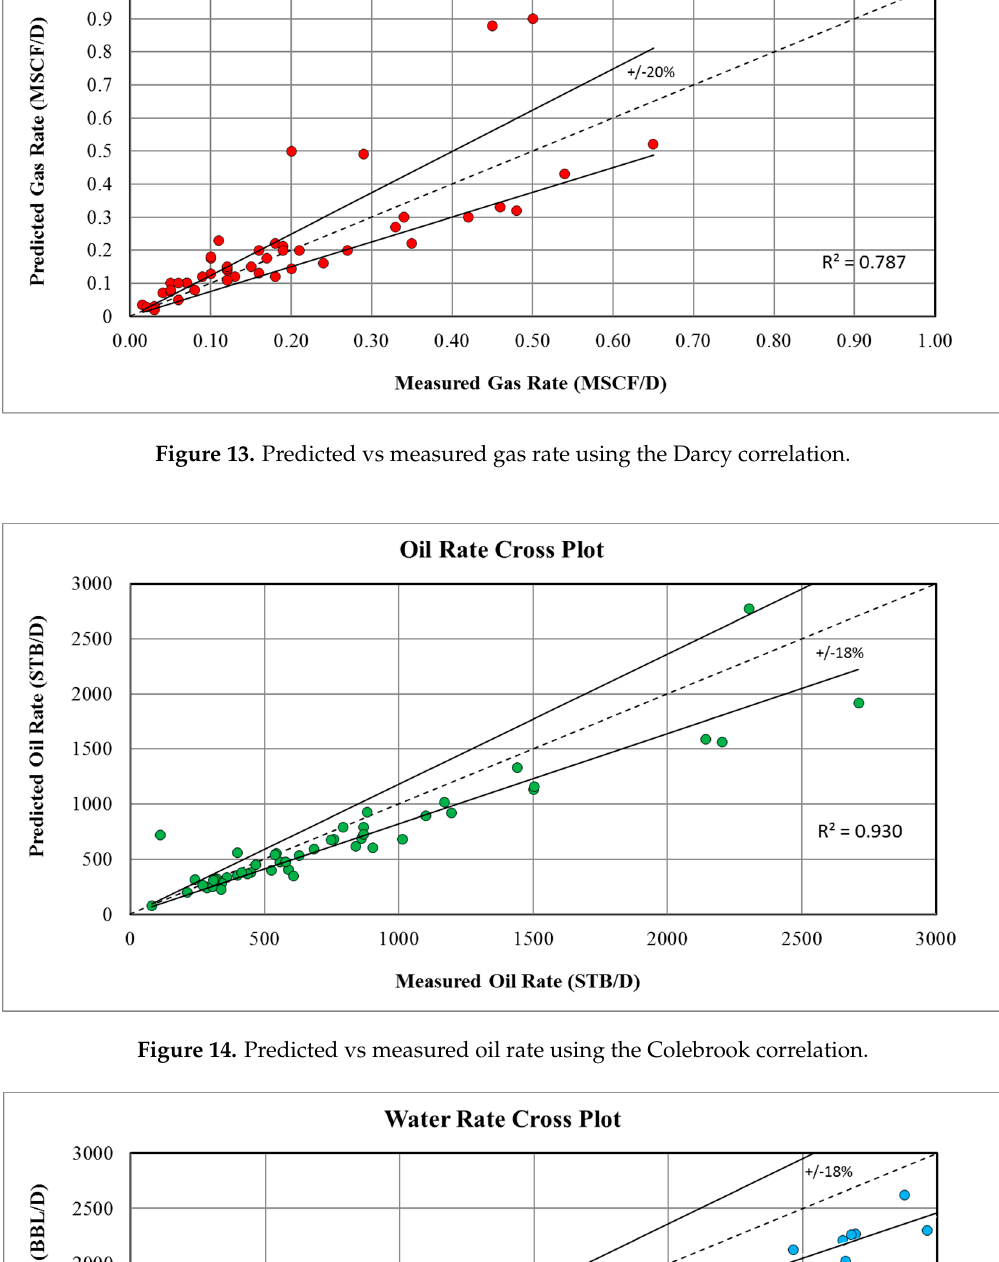
Figure 12. Predicted vs measured water rate using the Darcy correlation.